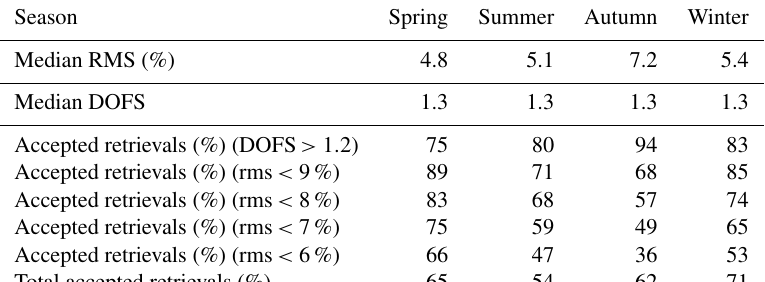
Table 3. Seasonally averaged root mean square (rms) and DOFS values. The rms is calculated between measured and retrieved NO 2 near- surface concentrations of the horizontal retrieval (Fig. 13). DOFS represent the degrees of freedom of the horizontal retrieval (Fig. 15). The percentage of the accepted retrievals is presented for the different selection criteria.